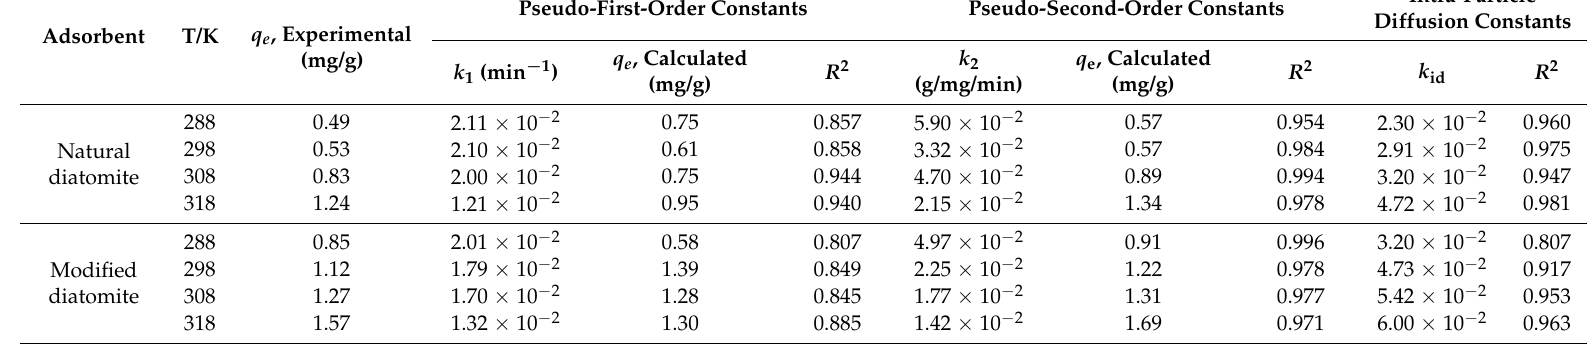
Table 1. Effect of temperature on 1-naphthol sorption on raw and modified diatomite: summary of intra-particle diffusion, pseudo-first and pseudo-second order kinetics